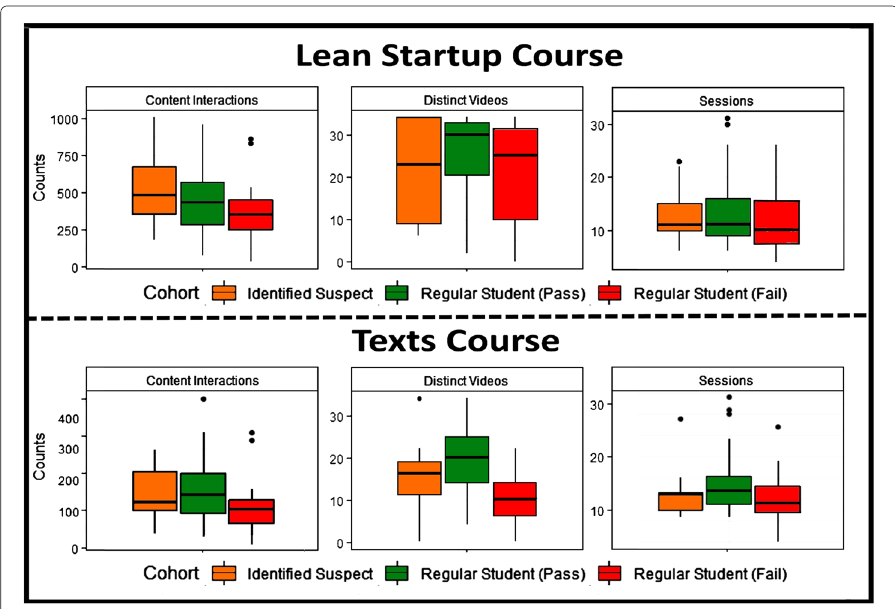
Fig. 4 Interaction of students with the contents of the